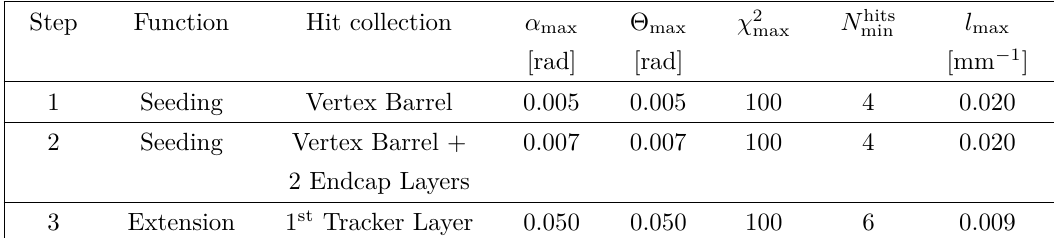
Table 1. Configuration of the conformal tracking used in this analysis. The parameters Θ max and α are the upper thresholds on the angle to connect two hits or two cells, respectively, max whereas χ 2 is the upper threshold on both linear regression fits performed in the conformal and max longitudinal planes. The minimum number of hits required in a track is indicated by N hits the upper threshold on the cell length in the conformal plane is referred to as l